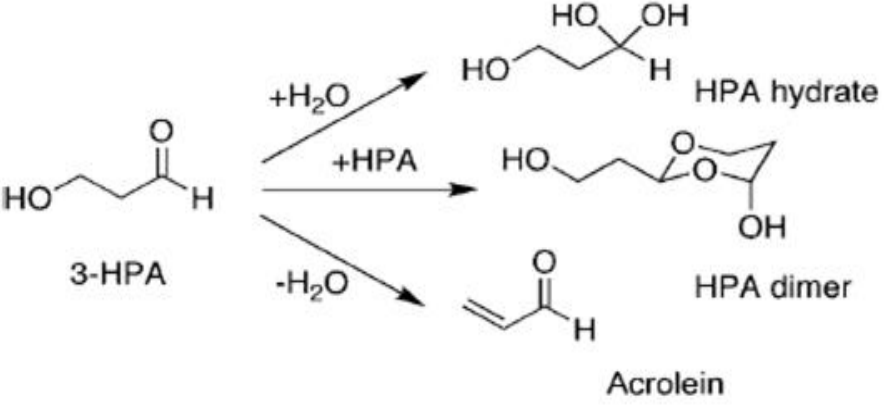
Figure 1. The structure of reuterin [7].